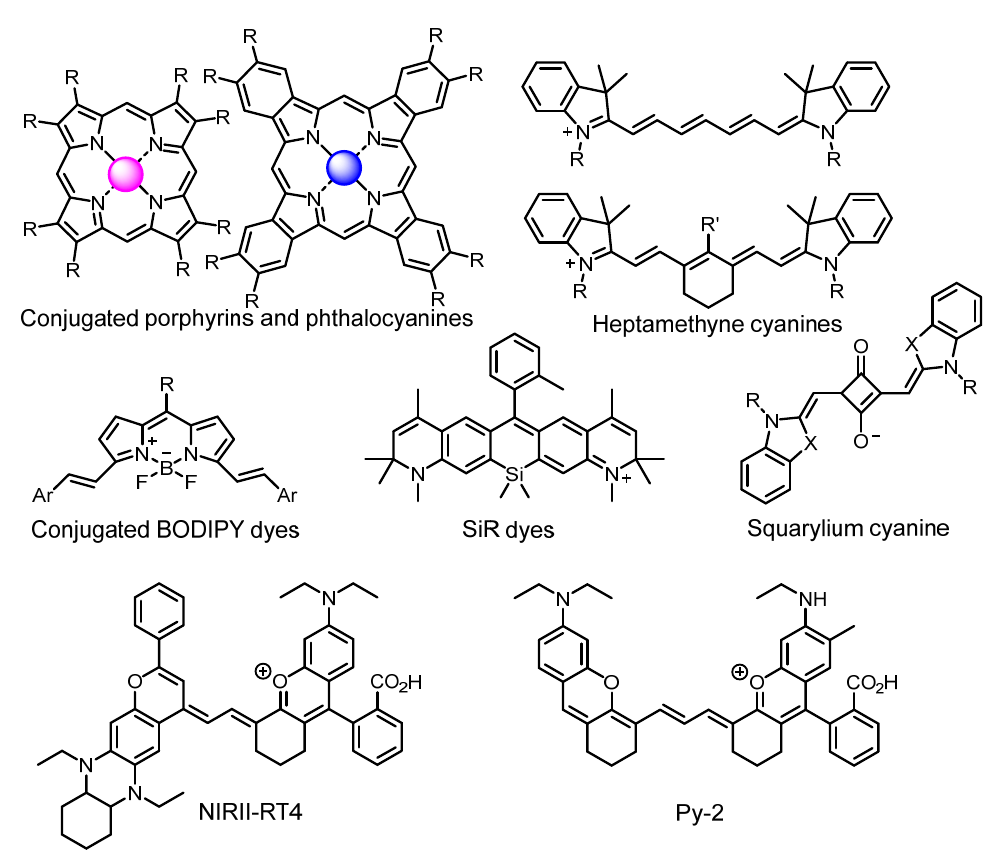
Figure 4. The main types of NIR dyes.